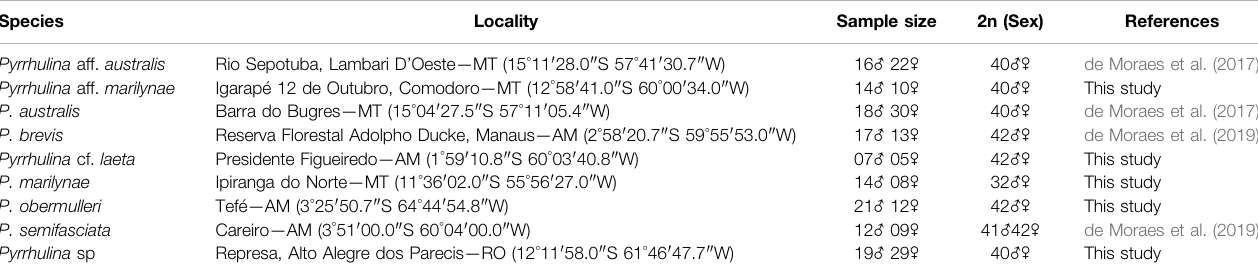
TABLE 1 | Geographical coordinates, sample size, and diploid number of Pyrrhulina (Characiformes, Lebiasinidae) species collected in Brazil. Species Locality Sample size 2n